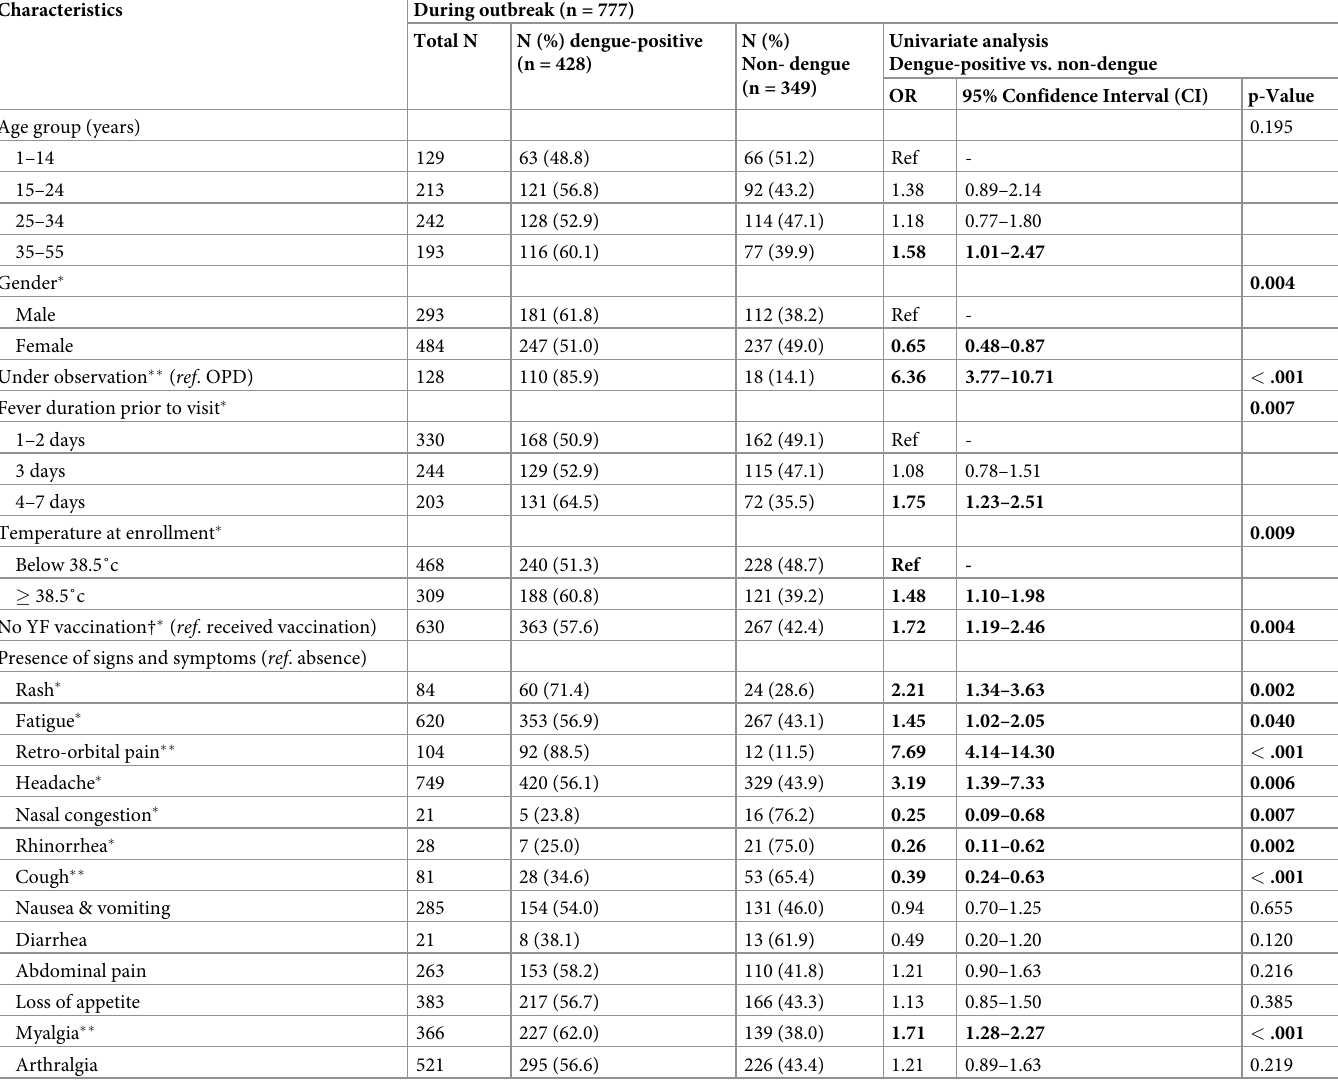
Table 3. Univariate logistic analyses showing significant indicators and their odds ratios of dengue-positivity during the outbreak period, from the facility-based fever surveillance established in Ouagadougou, Burkina Faso, between December 2014 and February 2017. Characteristics